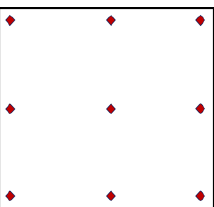
Figure 2. Sample forest plot (25m x 25m) showing the TLS scan positions used during data